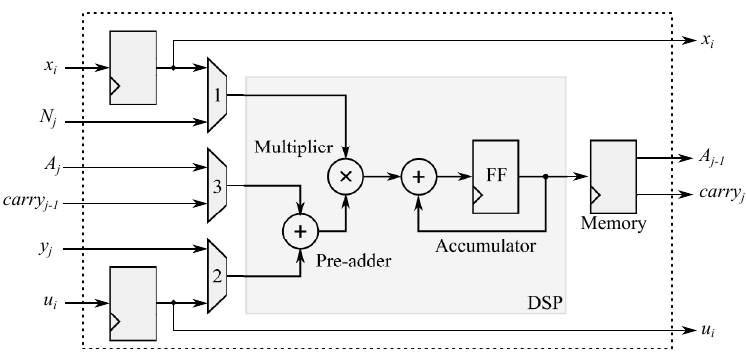
Figure 2. Block diagram of a processing element in